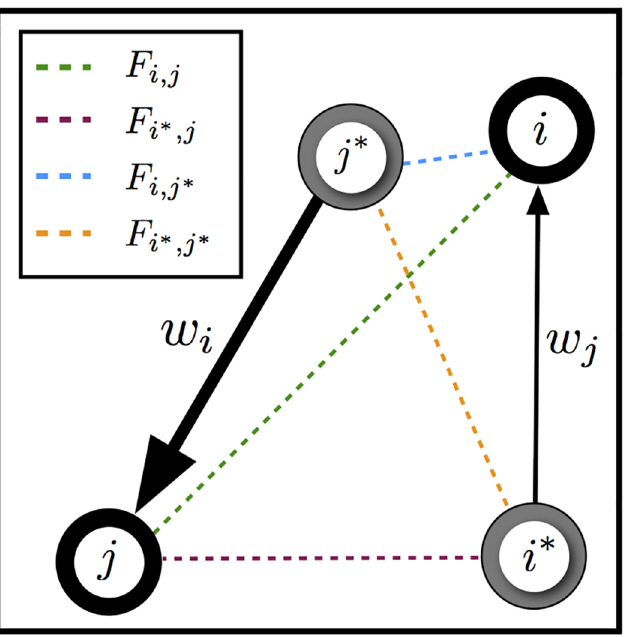
Fig 3. An illustration of the form of the admixed covariance. Following Eq (6), populations i and j are drawing admixture in proportions w i and w j from their respective sources of admixture, i * and j * , and all pairwise spatial covariances (the F ’ s) are shown. In this cartoon example, population j is drawing more admixture from its source j * than i is from its source i * (i.e., w j > w i